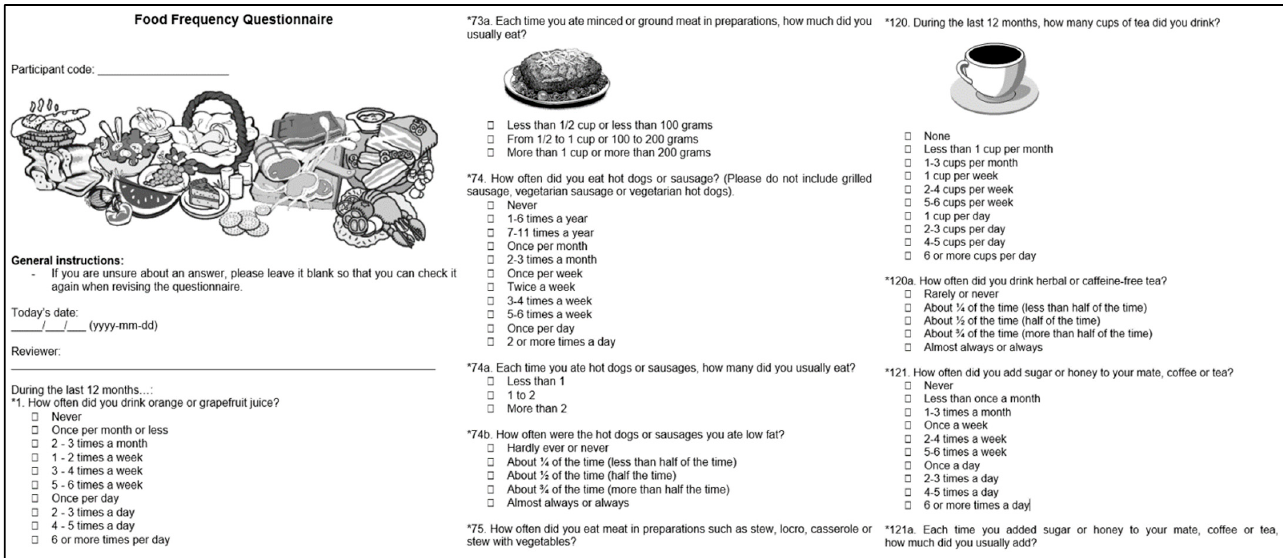
Figure 5. English translation of exemplary screenshots of the food-frequency questionnaire integrated in EULAT eCollect .